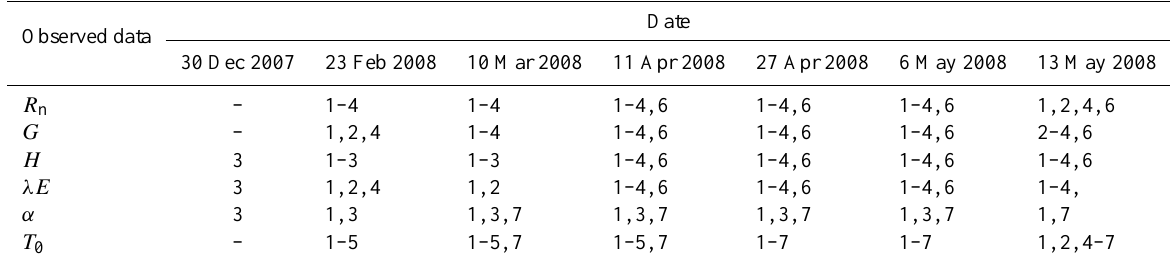
Table 2. EC stations used to compute performance statistics at each date. Correspondence of numbers and stations : (1) wheat (east), (2) wheat (west), (3) broccoli/beans, (4) chickpea, (5) chili pepper, (6) potatoes/sorghum and (7) safflower. Observed data